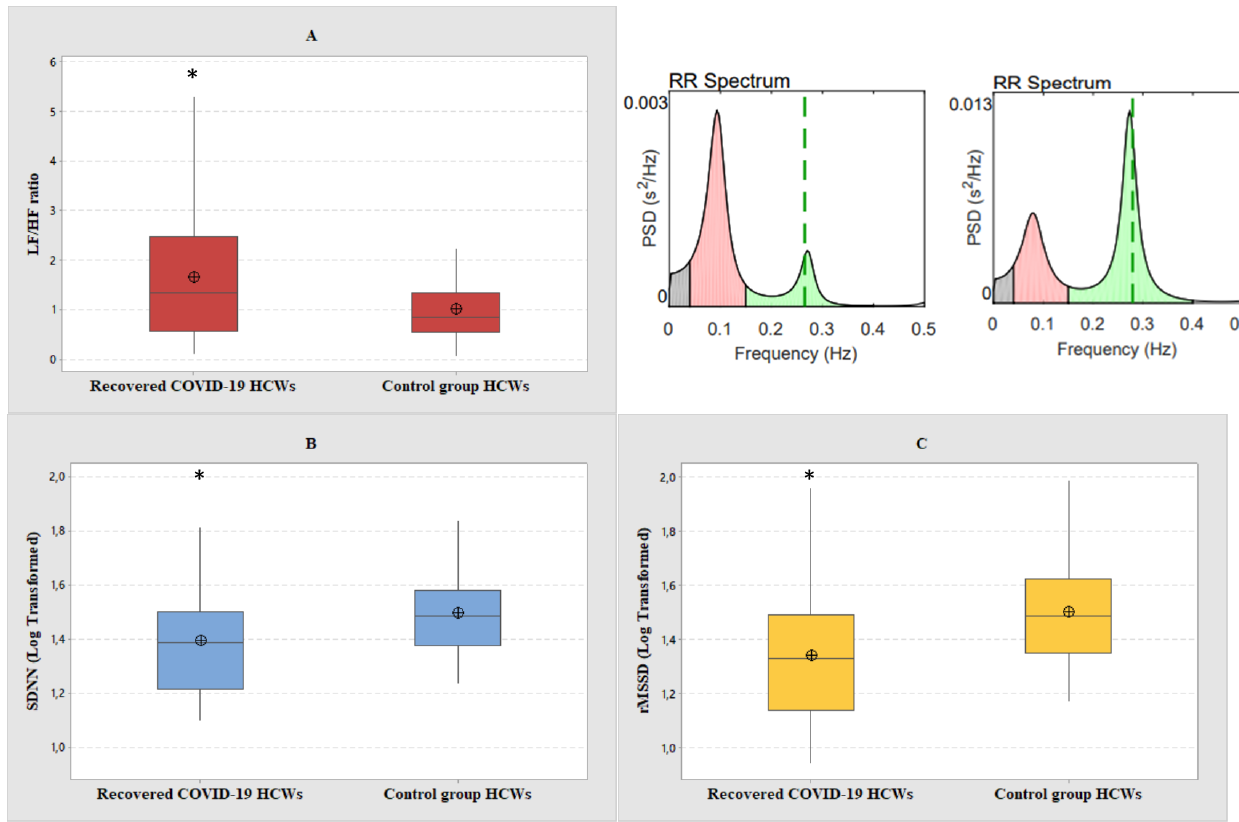
Figure 2. Boxplot graphical representation of ( A ) LF/HF ratio, ( B ) SDNN, log transformed values, and ( C ) RMSSD, log transformed values, among recovered COVID-19 and control group HCWs. In the upper right corner is reported the RR spectrum of a case (on the left) and its control (on the right). In box plots, the boundary of the box closest to zero indicates the 25th percentile, the line within the box marks the median, and the boundary of the box farthest from zero indicates the 75th percentile. The whiskers (error bars) above and below the box indicate the 95th and 5th percentiles. The circle with the inner cross indicates the mean value. *Student's t-test, level of significance < 0.05.